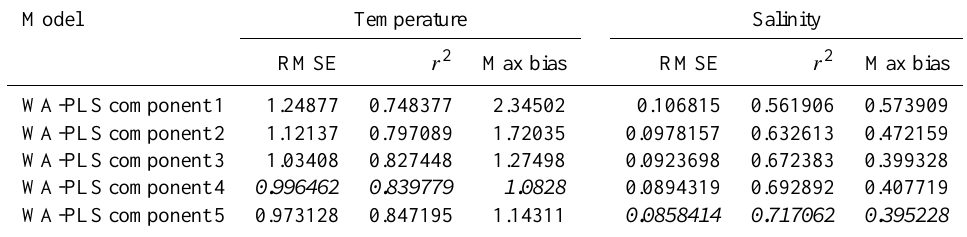
Table 2. Performance of transfer function model WA-PLS with components 1 to 5. Italics indicate performance of the selected models.